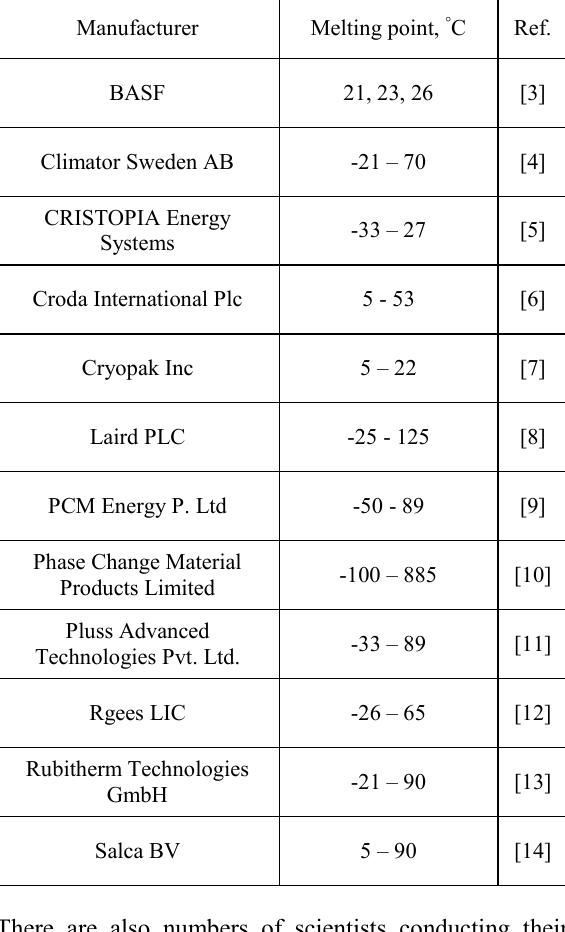
Table 1. Selected companies manufacturing